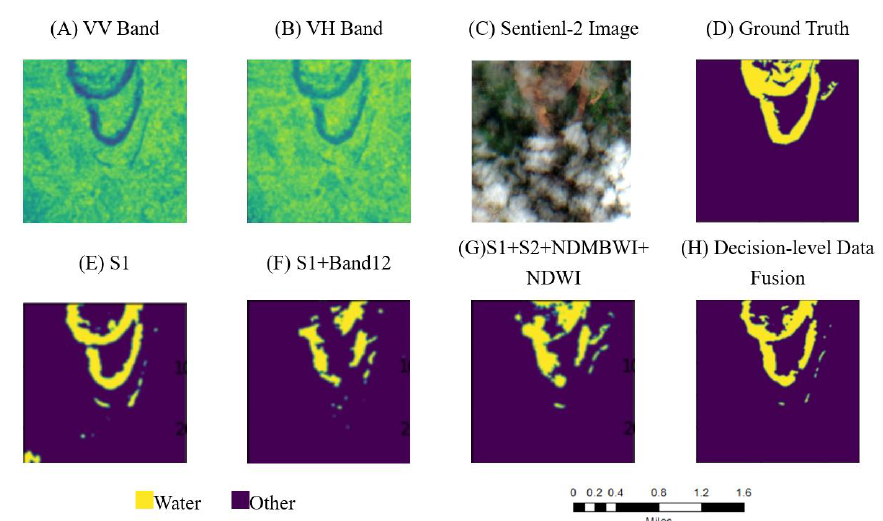
Figure 6 . Results of data fusion in cloud